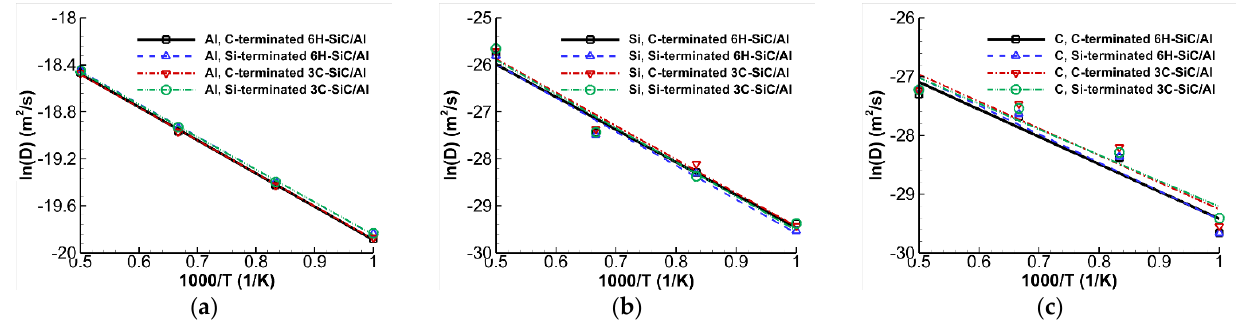
Figure 8. Arrhenius plots of ( a ) Al, ( b ) Si, and ( c ) C atoms for the C − and Si − terminated 6H − SiC/Al and 3C − SiC/Al interfaces.